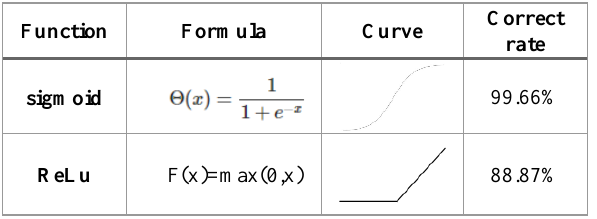
Table 3. Comparison of Two Activation Functions